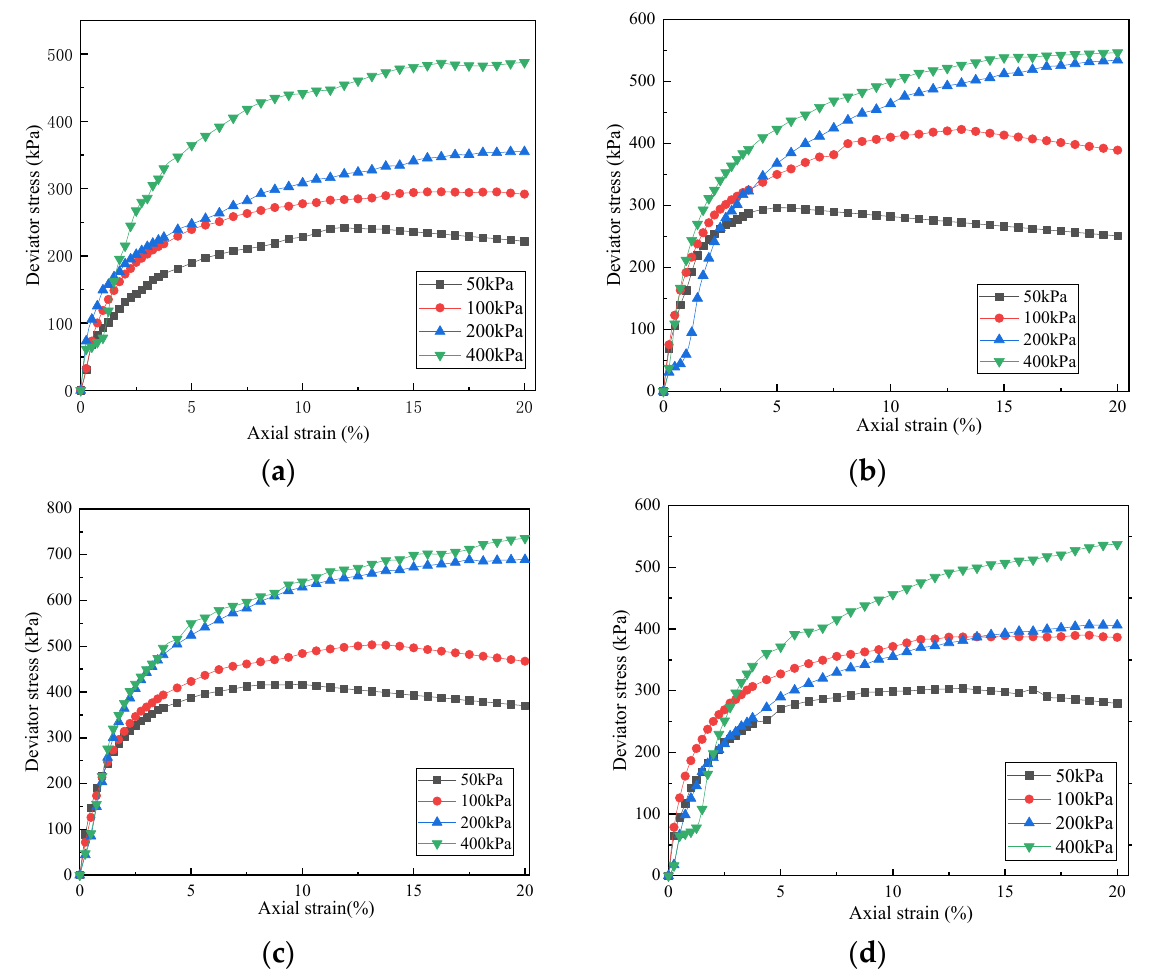
Figure 5. Stress-strain curves of red clay with different dosages of F1 agent. ( b ) 0.0 L/m 3 . ( b ) 0.3 L/m 3 . ( c ) 0.5 L/m 3 . ( d ) 0.7 L/m 3 .